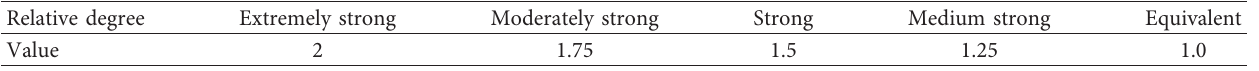
Table 2: Importance level of